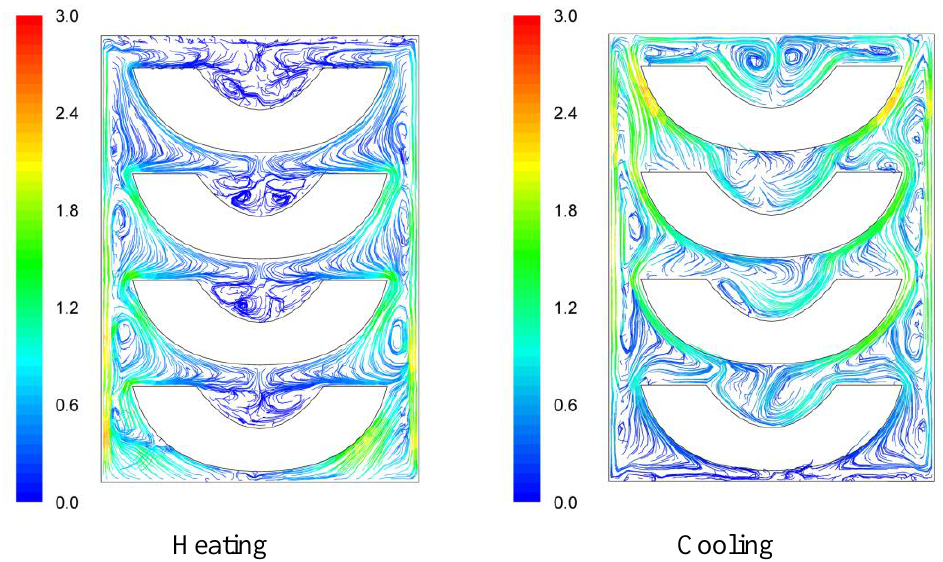
Figure 3. Velocity pathlines after 30 s of heating (left) and after 30 s of cooling (right) for the “upward” case (velocity in cm/s).